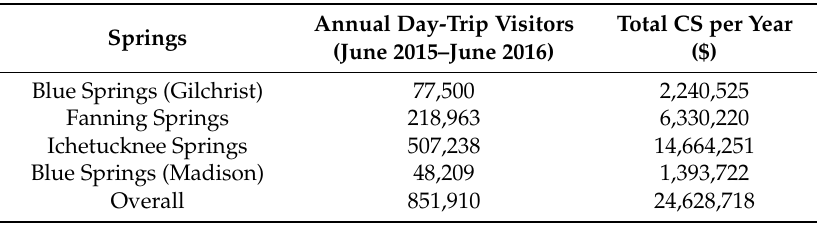
Table 5. Total consumer surplus